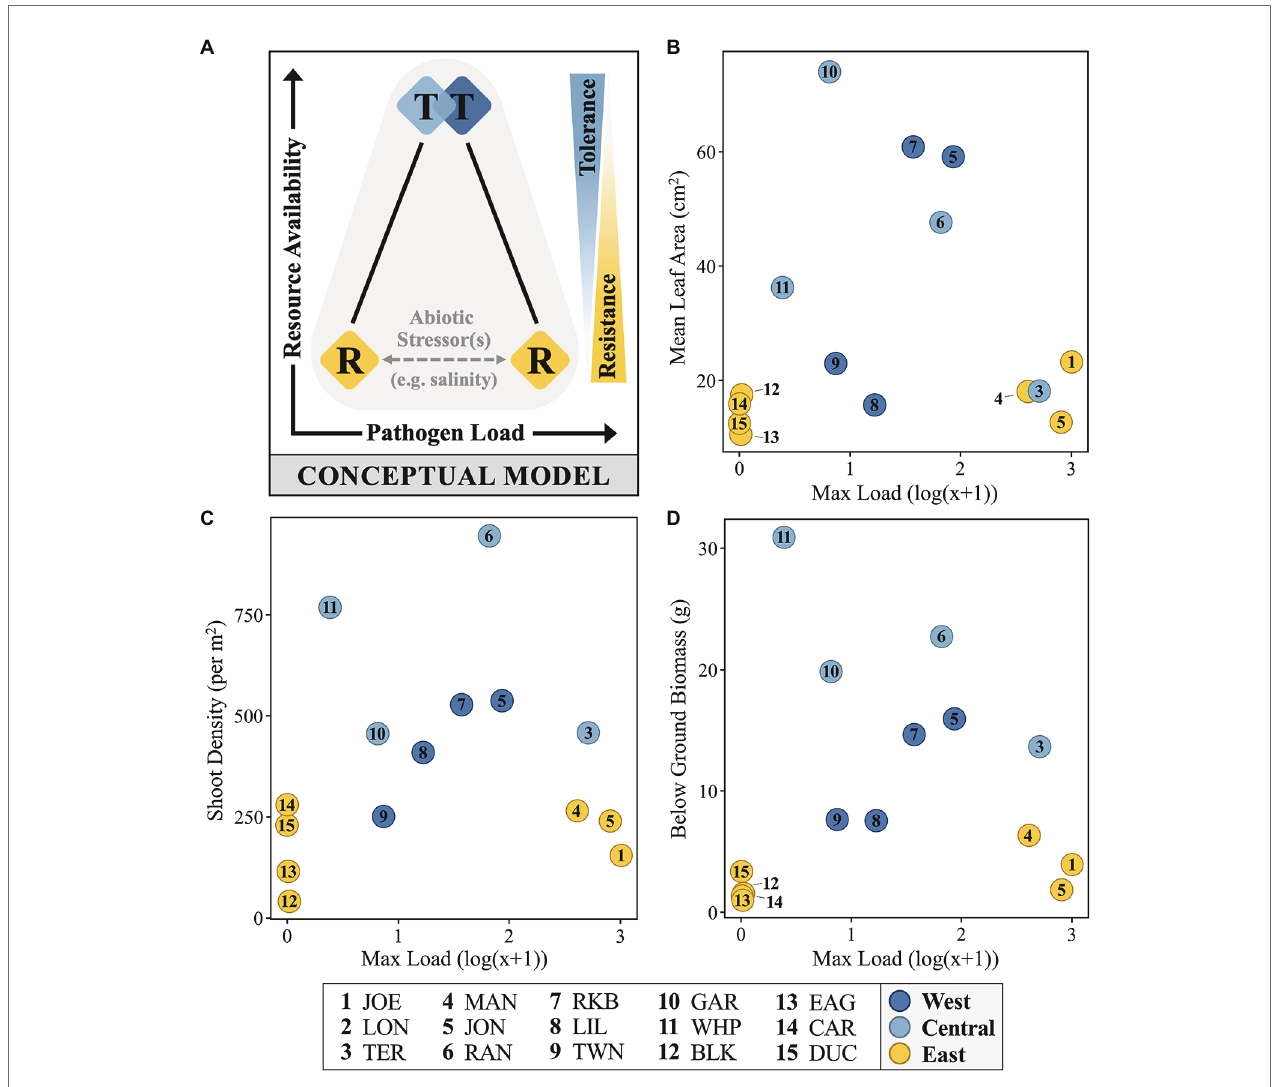
FIGURE 6 | A conceptual model (A) and selected fitness metrics (B–D) relating immunostatus, Labyrinthula pathogen loading and host phenotype of FB turtlegrass. In part (A) , colored diamonds represent field measures of mean immune zone responses adopting a strategy somewhere along the tolerance (“T”) and resistance (“R”) continuums (represented as blue/yellow wedge gradients, right). Measures of pathogen load and resource availability increase along the x - and y -axes, respectively. Influence of abiotic stressors (represented by gray horizontal dashed line), such as salinity stress, is suggested to play a role in determining pathogen load in hosts presenting with a strategy of resistance (“R”). In parts (B–D) , data are plotted along similar x - and y -axes as in the conceptual model; here, pathogen load is represented as the log(x + 1) value of the most infected individual at a given site and resource availability is substituted with three measures of morphological data that serve as reasonable proxies for plant fitness: mean leaf area (cm 2 ), shoot density (per m 2 ), and below ground biomass